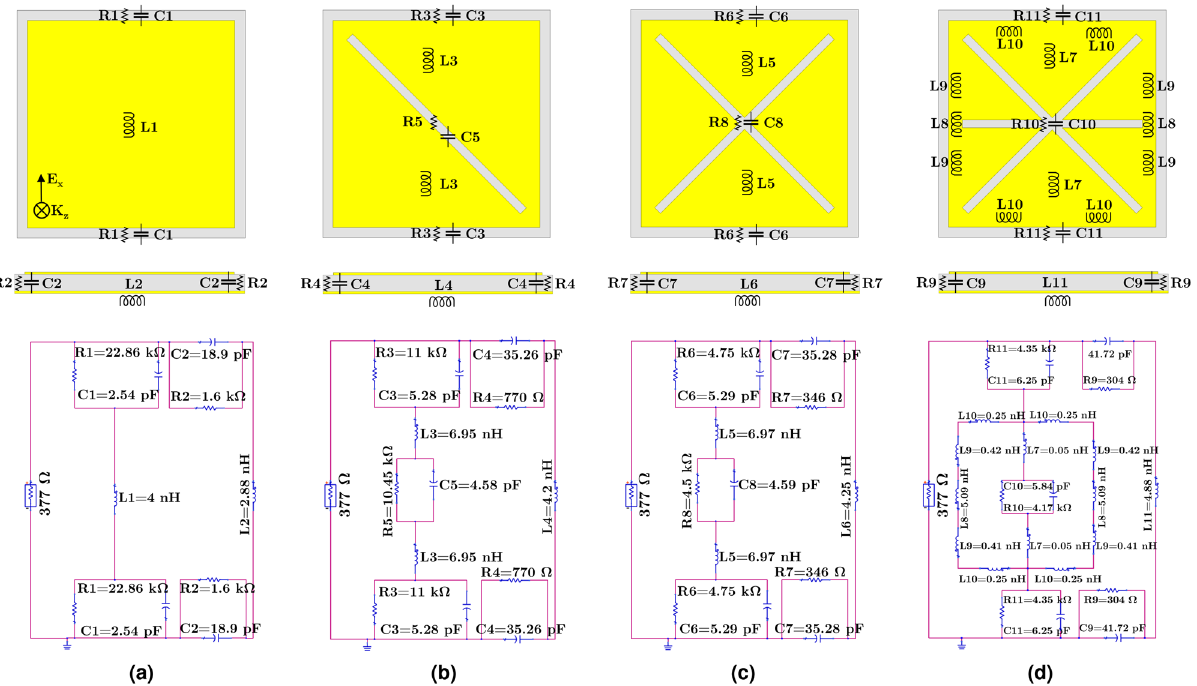
Figure 5. Equivalent electrical model for the unit-cell design steps representing the location of the corresponding lumped components in their structures: ( a ) unslotted patch; ( b )–( d ) slotted patch with one, two, and three slits,